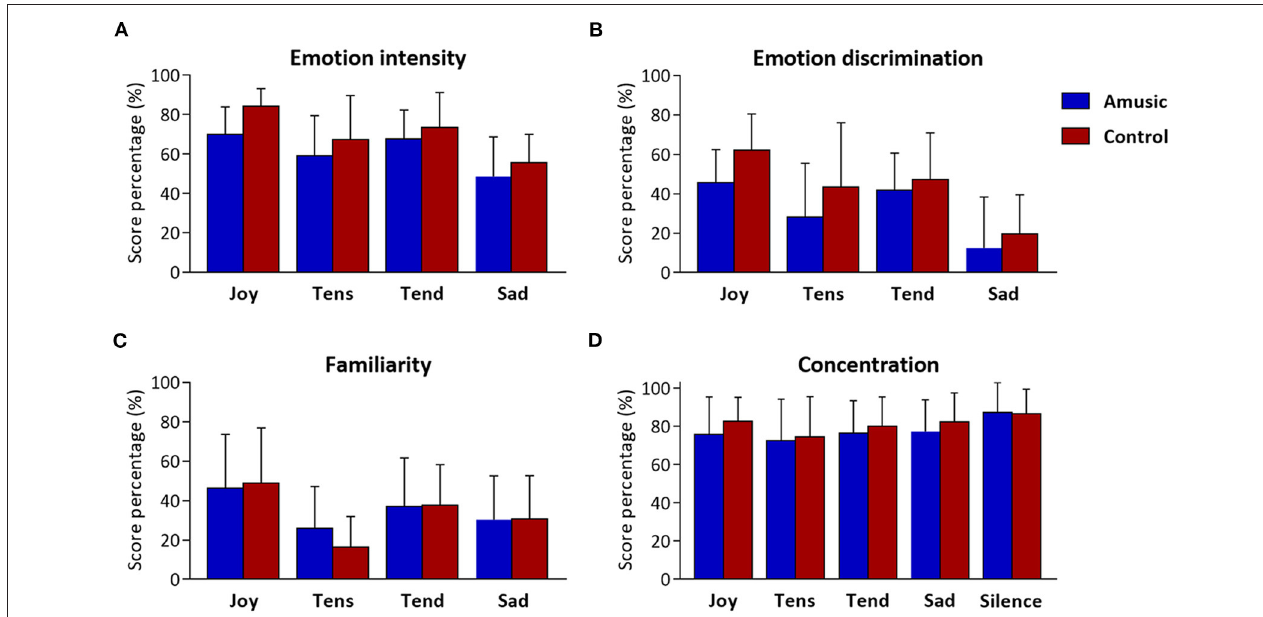
FIGURE 3 | Music and concentration ratings obtained at the end of musical blocks. Scores resulting from (A) emotion intensity, (B) emotion discrimination (i.e., discrimination ratio), and (C) familiarity are presented as percentages (%) for each of the four emotion categories (i.e., Joy, Tension, Tenderness, and Sadness), for amusic and control participants separately. Concentration scores (D) are presented (%) for each of the five auditory conditions (including silence) for the two groups